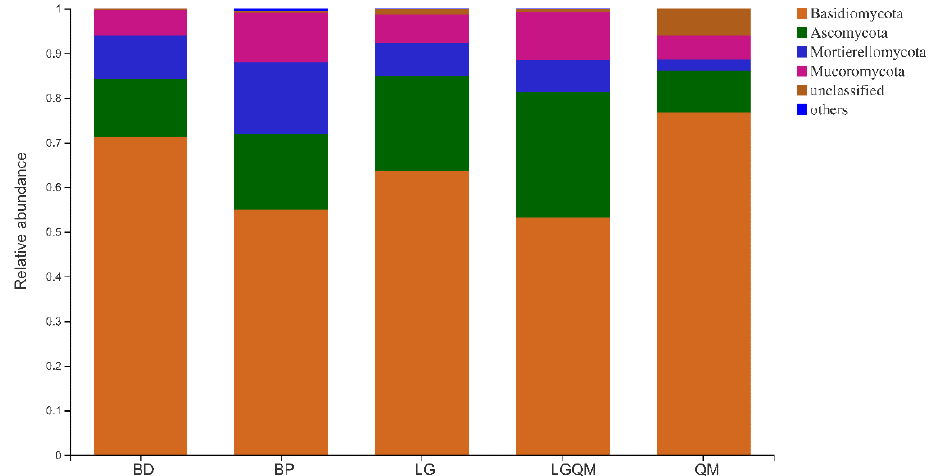
Figure 4. Effect of revegetation type on the relative abundance of fungal phyla. BD, Betula dahurica ; BP, Betula platyphylla ; LG, Larix gmelinii ; LGQM, Q. mongolica and L. gmelinii mixed forest; QM, Quercus mongolica .